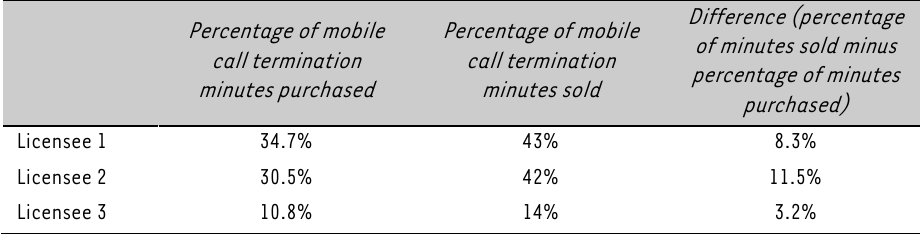
Proportion of mobile terminating minutes purchased and sold by each MNO licensee, January to June 2009